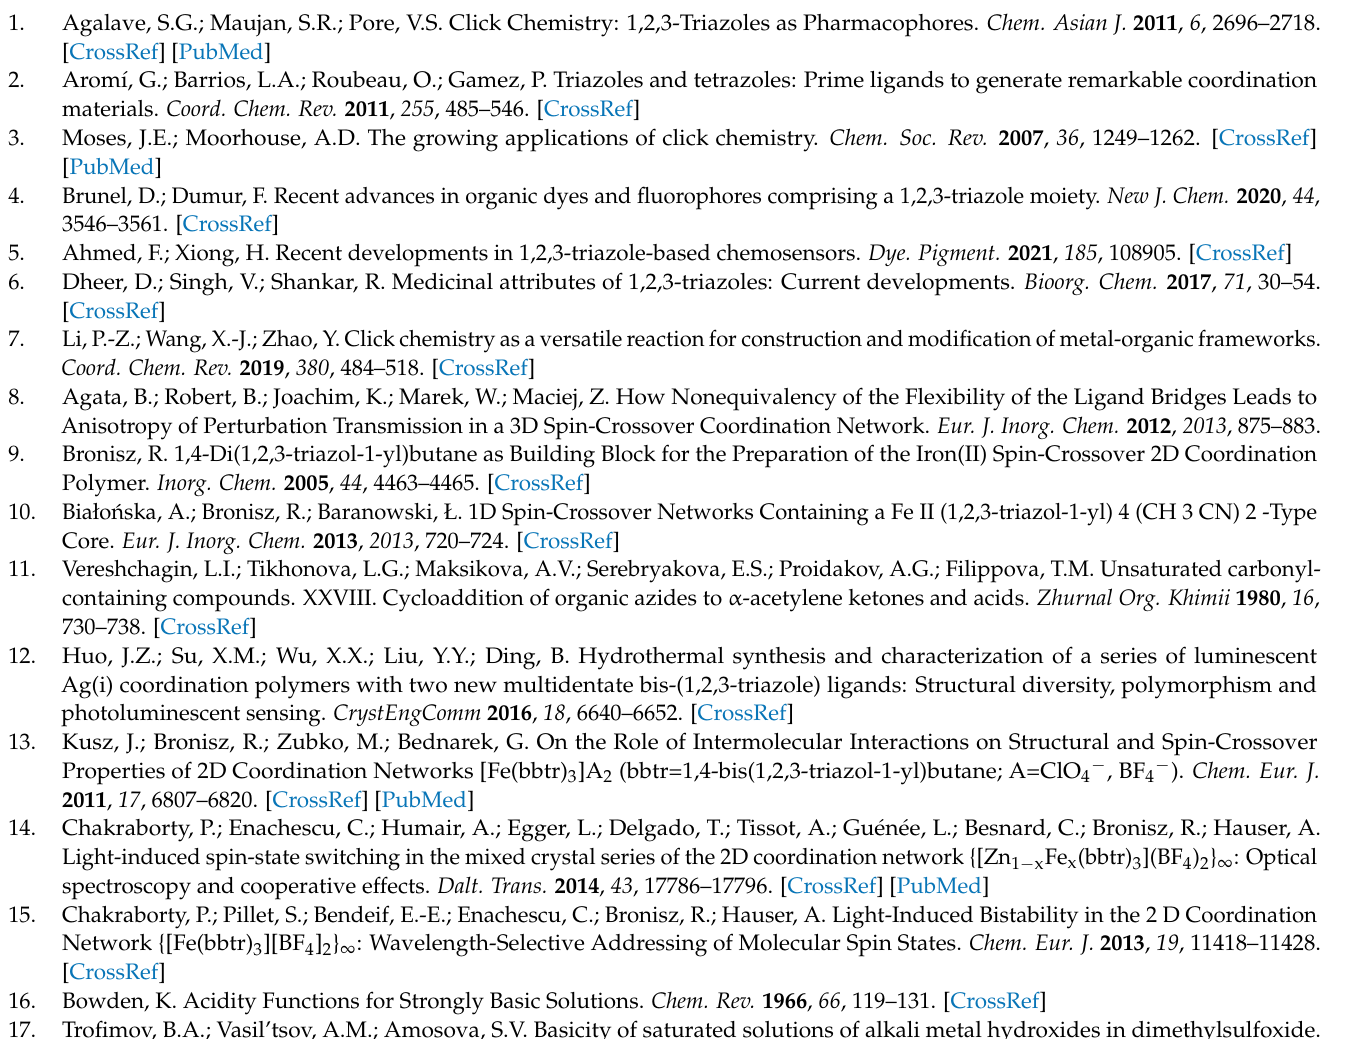
Figure S15. FT-IR spectrum of 1-(1,2,3-triazol-1-yl)-2-(1,2,3-triazol-2-yl)methane 2b